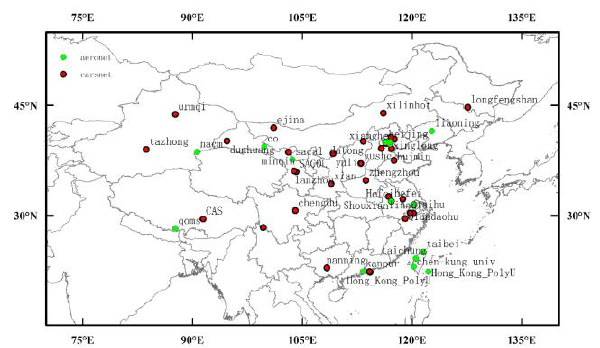
Figure 1. Spatial distribution of AERONET (red points) and CARSNET (green points) sites in